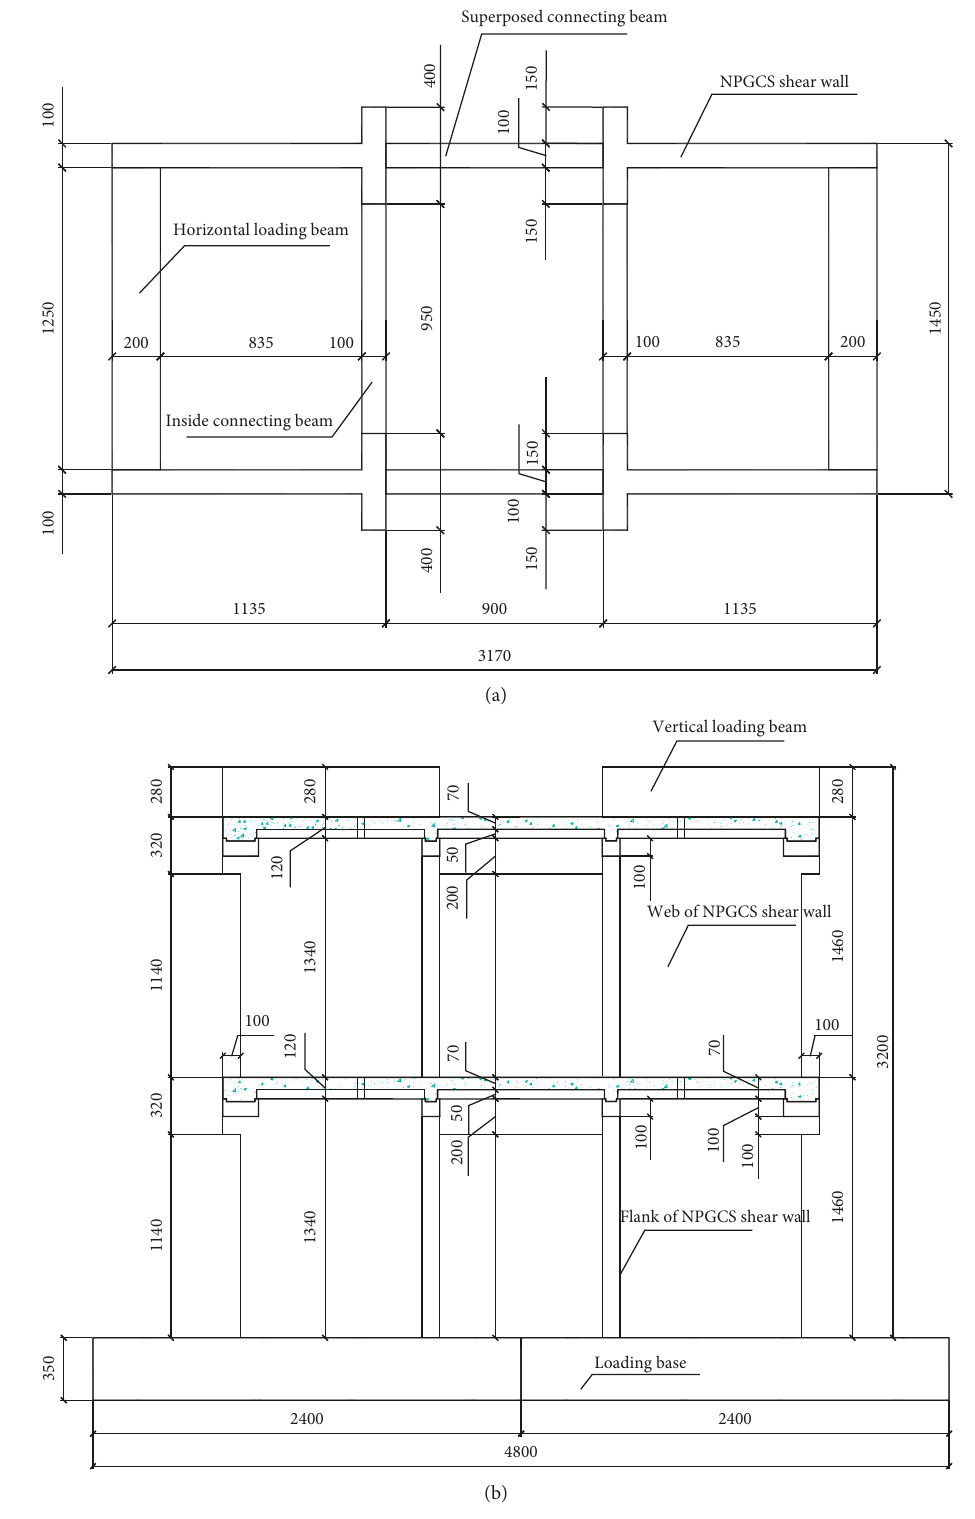
Figure 6: Sizes of the NPGCS spatial model. (a) Plane section. (b) Vertical